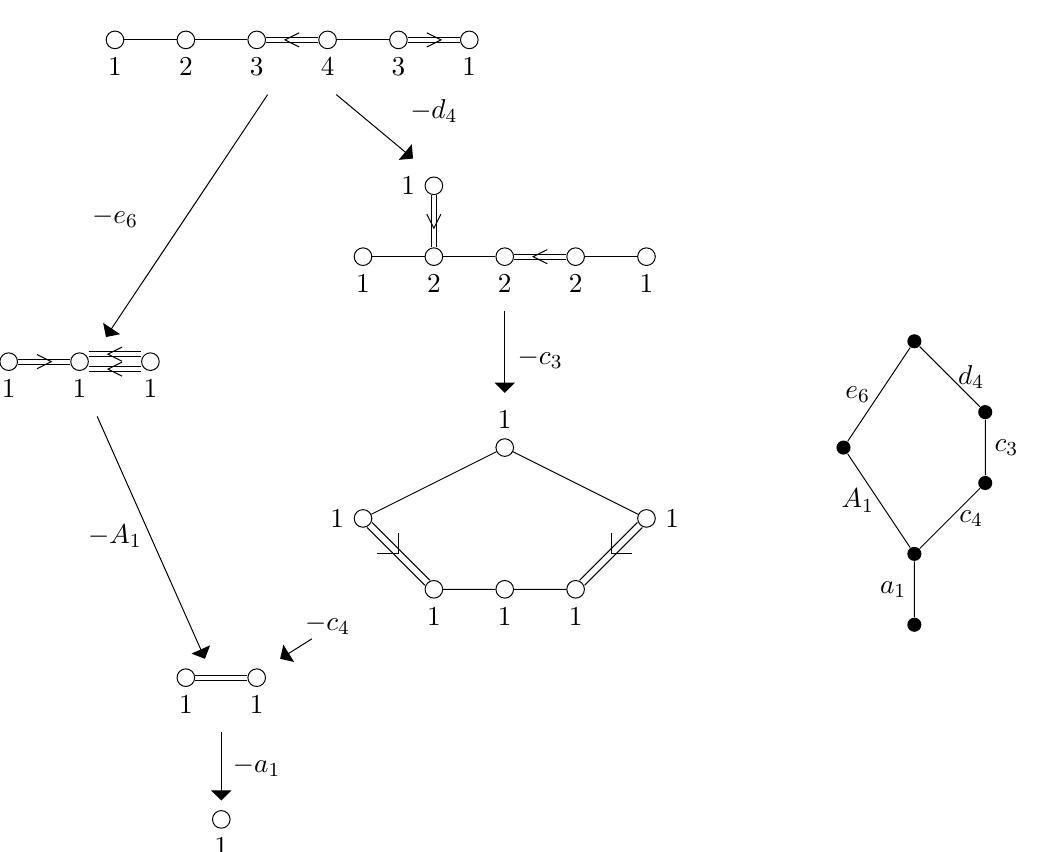
Figure 2 . Left: quiver subtraction for the magnetic quiver of theory # 34. The quiver after the e 6 subtraction contains two non-simply laced edges connecting the right node to the middle node, allowing for an A 1 subtraction. Right: Hasse diagram resulting from quiver